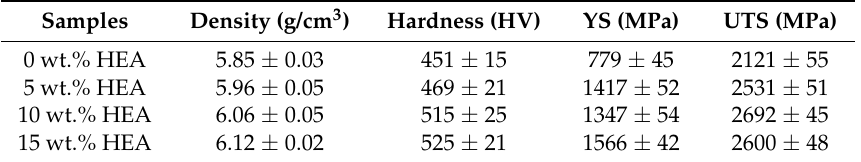
Table 2. Density, hardness, and compressive properties of composites with different HEA contents.